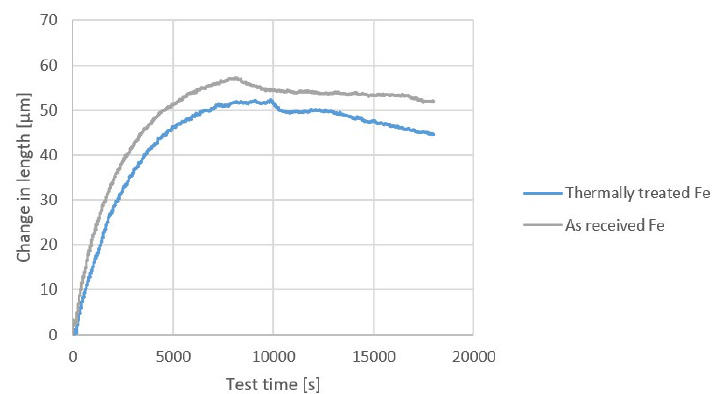
Figure 6. Dilatometric measurement of hydrogen-charging.